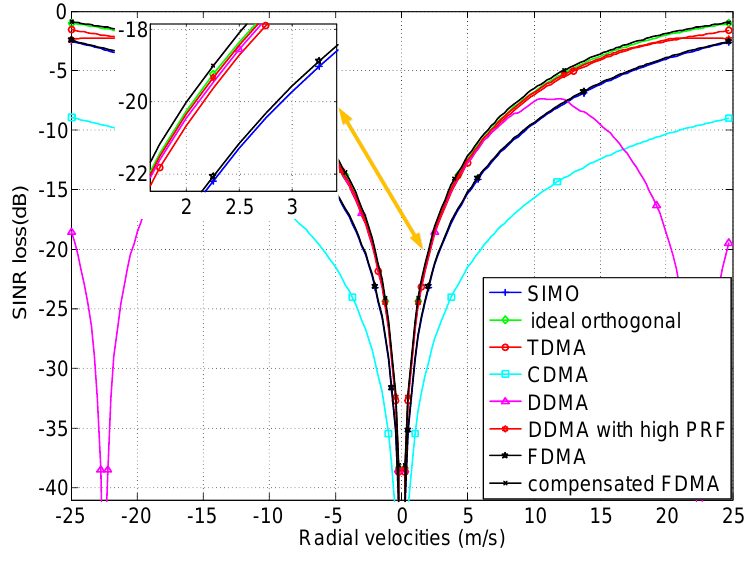
Figure 5. SINR loss of MIMO GMTI radar with different